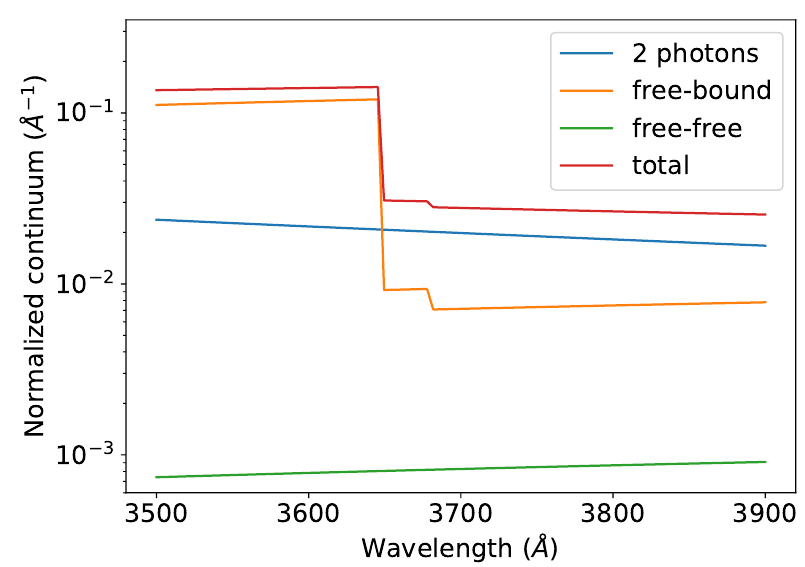
Figure 2. Nebular continuum normalized to H I 3770Å. The data are obtained with the get_continuum function of the Continuum class for T e = 10 4 K, n e = 10 2 cm − 3 , He + /H + = 0.12, and He ++ /H + =